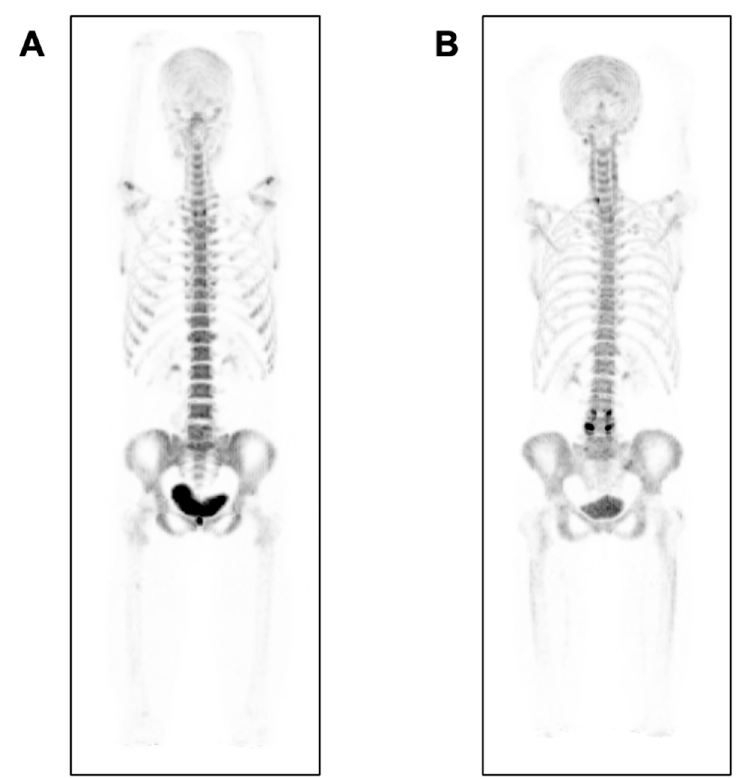
Figure 3. Aging and 18 F-NaF uptake in the bone. Maximum intensity projection 18 F-NaF-PET images of two healthy subjects, ( A ) a 26-year-old female and ( B ) a 62-year-old female. The difference in 18 F-NaF uptake is visible particularly in the spine, pelvis, and proximal femur, which can be quantified in longitudinal studies to monitor disease progression and therapeutic